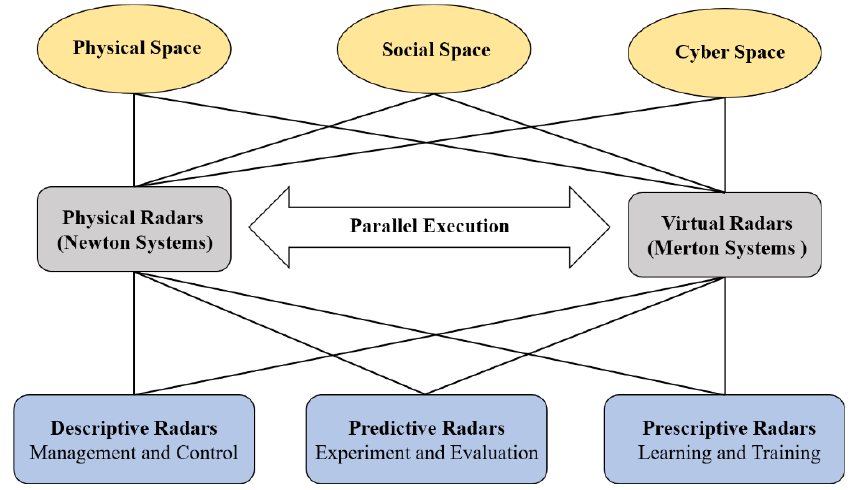
Figure 3. The framework of Parallel